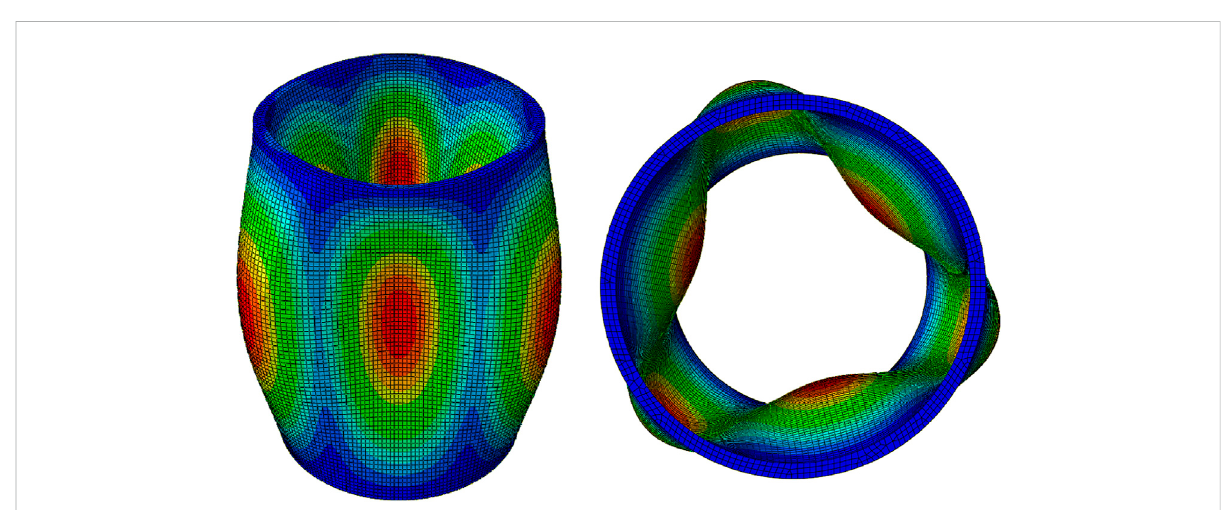
Figure 4 Finite element calculation of global buckling mode.